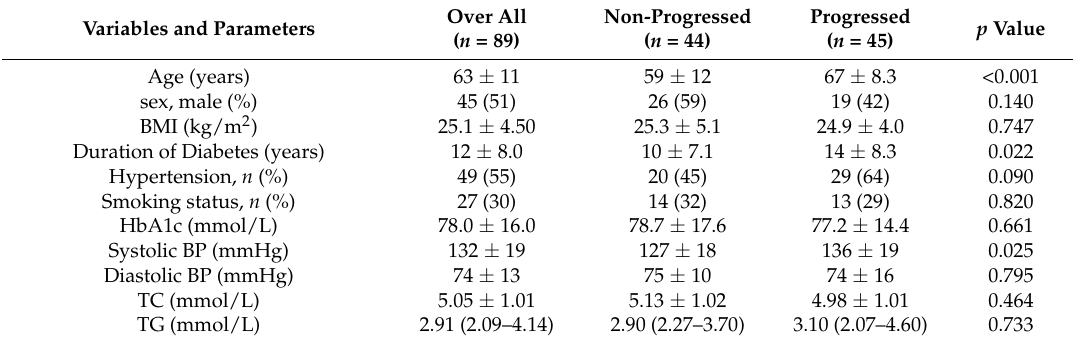
Table 1. Baseline demographic data of participants and differences between the progressed group and the non-progressed